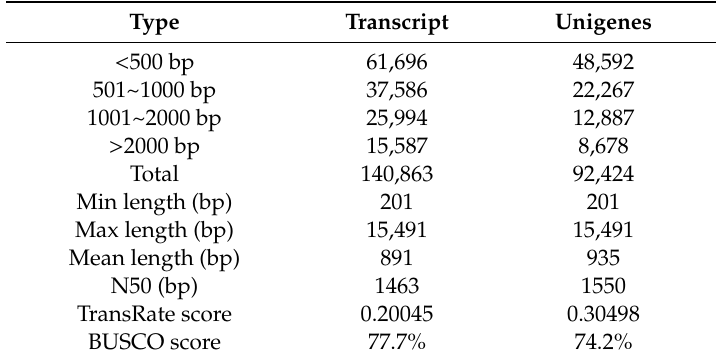
Table 2. Length distribution and software evaluation of unigenes and